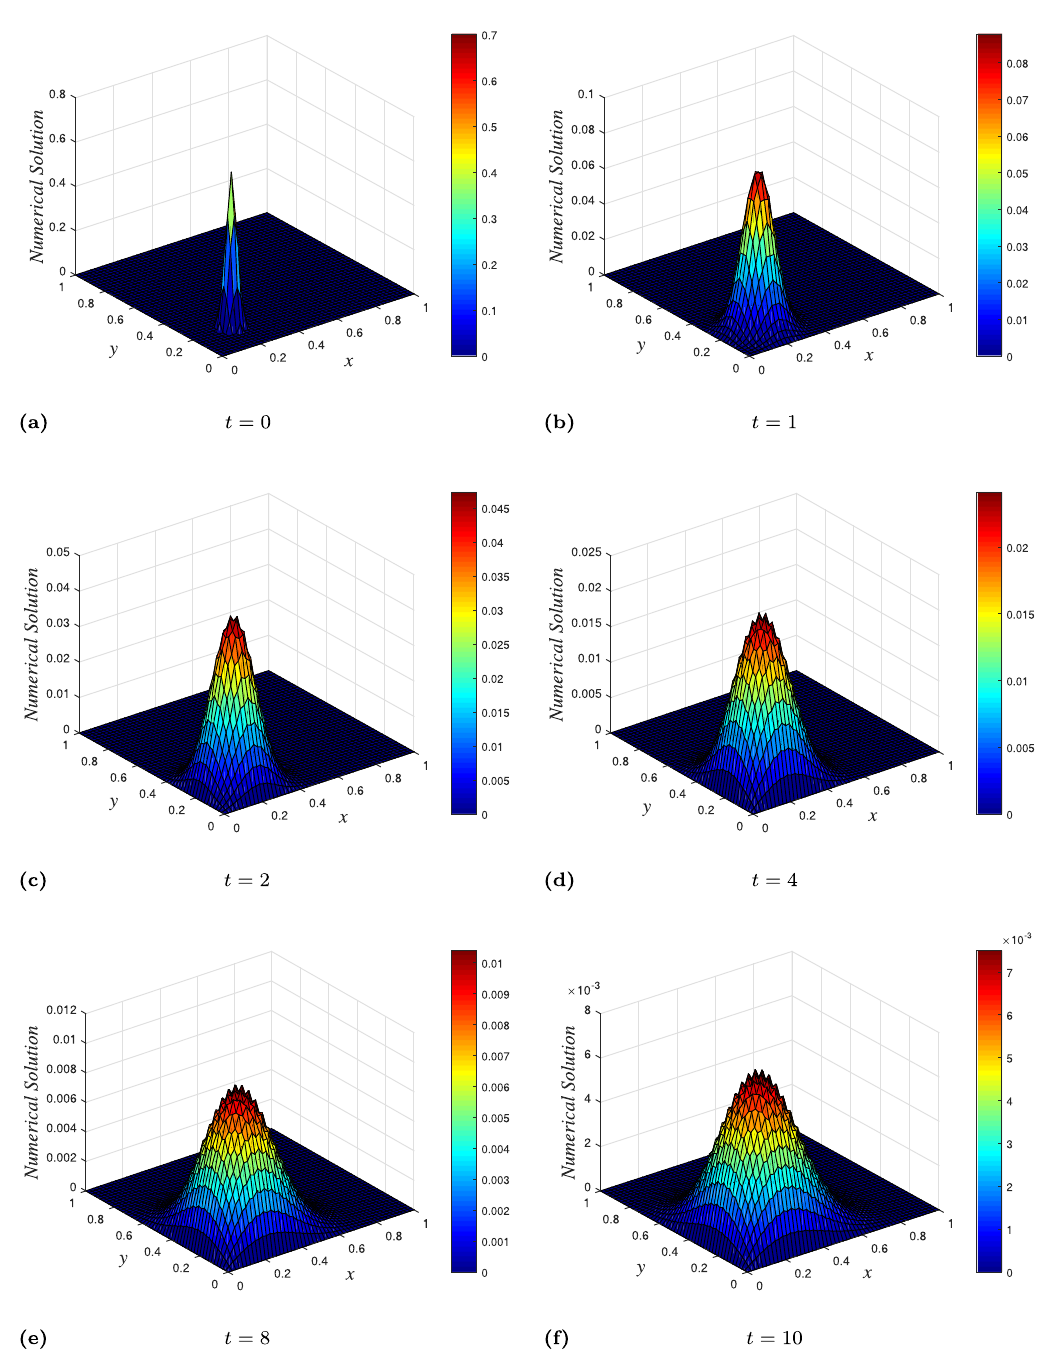
Figure 1: Plot of numerical solution vs x vs y using classical scheme at times = t 0, 1, 2, 4, 8 , and 10 with spatial step sizes = = h h 0.02 x y and time - step = k 0.05 . ( a ) = t 0 . ( b ) = t 1 . ( c ) = t 2 . ( d ) = t 4 . ( e ) = t 8 . ( f ) = t 10